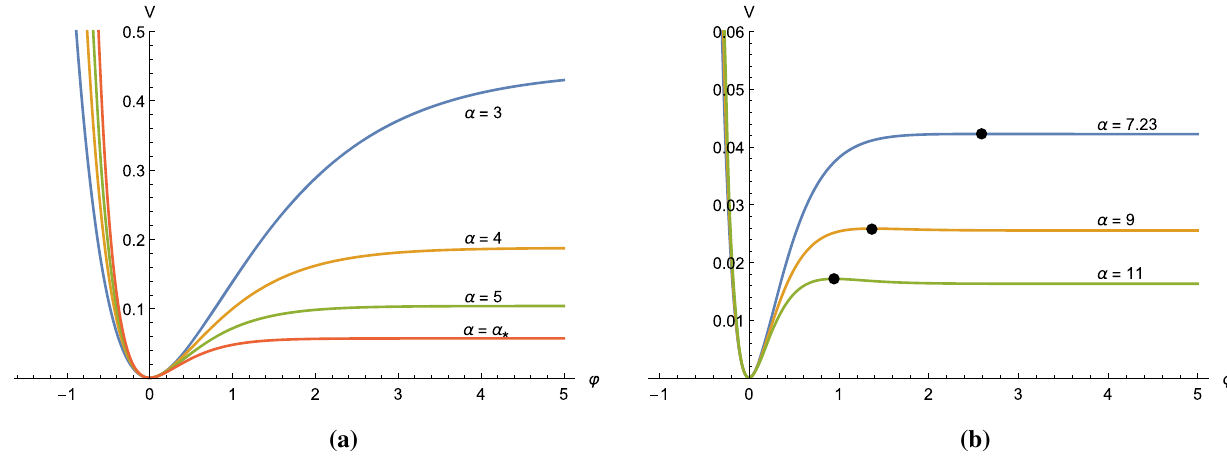
( a ) (b) Fig. 2 The scalar potential (41)(47) at τ = 0 for μ = 2, λ = 1, V 0 = 0 and different values of α . Subfigure a includes some Starobinsky-like examples, including the marginal case α ∗ ≈ 6 . 37. Subfigure b includes hilltop examples where the marker points represent local